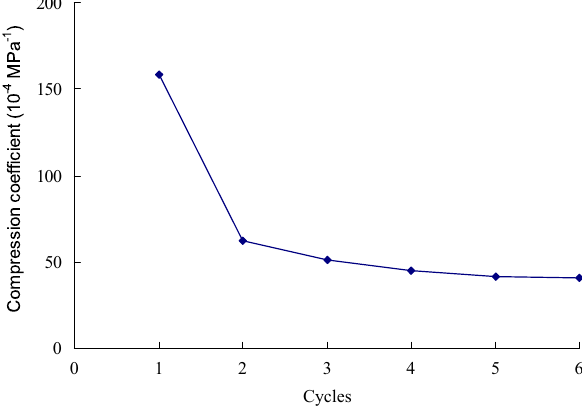
Fig. 5 Change laws of the compression coefficient with cycles (the effective confining pressure is 9 MPa; the temperature is 280 (cid:3)